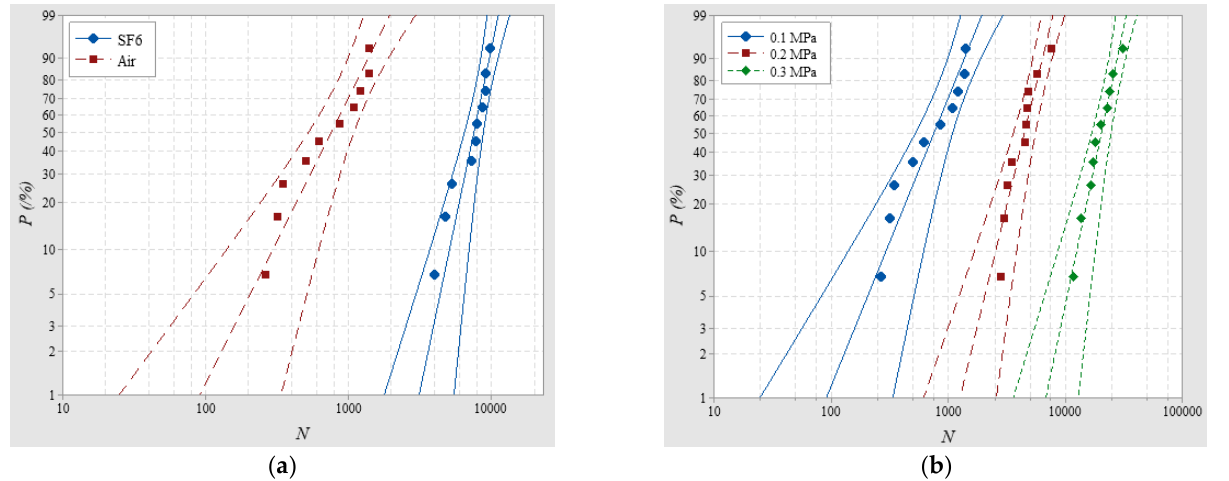
Figure 4. SILs vary with ( a ) different gases and ( b ) different pressures.